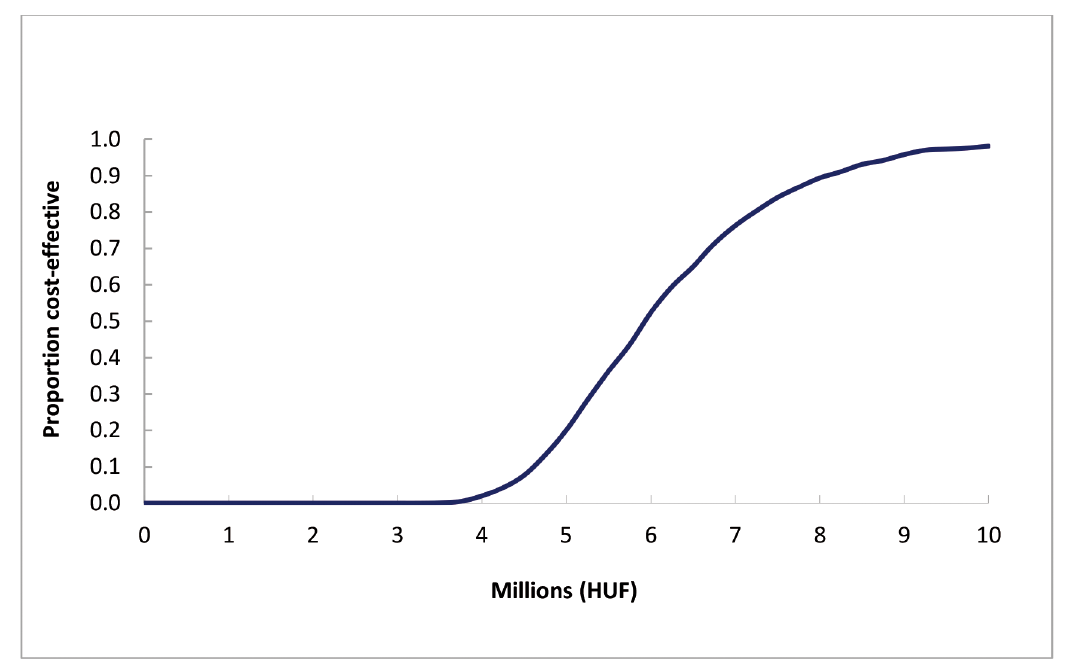
Figure 7. Cost-effectiveness Acceptability Curve in Treatment-experienced Patients